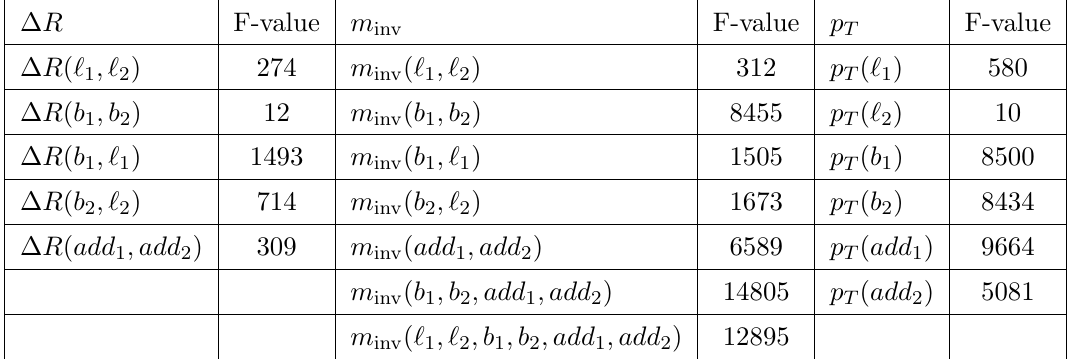
Table 3 . Kinematical variables used in the neural network. The F-values denote the results of the ANOVA (Analysis of variances)